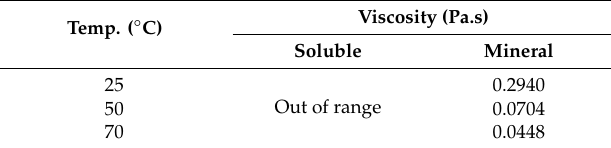
Figure 3. Experimental results obtained in C-type copper wire drawing process with mineral and soluble lubricants for di ff erent speeds. Table 1. Dynamic viscosity at di ff erent